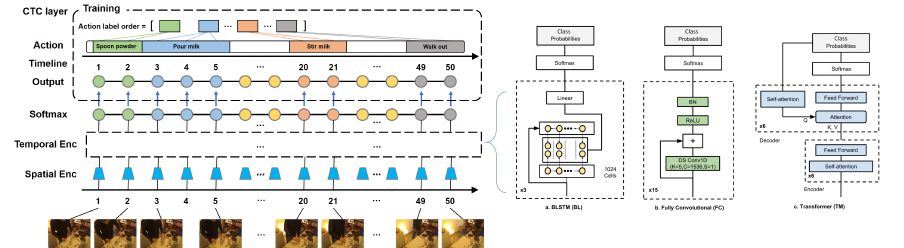
Figure 2. The proposed Hybrid-CTC structure consists of a hybrid encoder with a CTC output layer. See Table 3 for architectural details of different temporal encoders. See Figure 4 and Section 3.4 for how the CTC layer aggregates all possible input–output alignments. See Section 4.1 for how to sub-sample frames from raw video as pre-processing before submitting to CNN encoders.